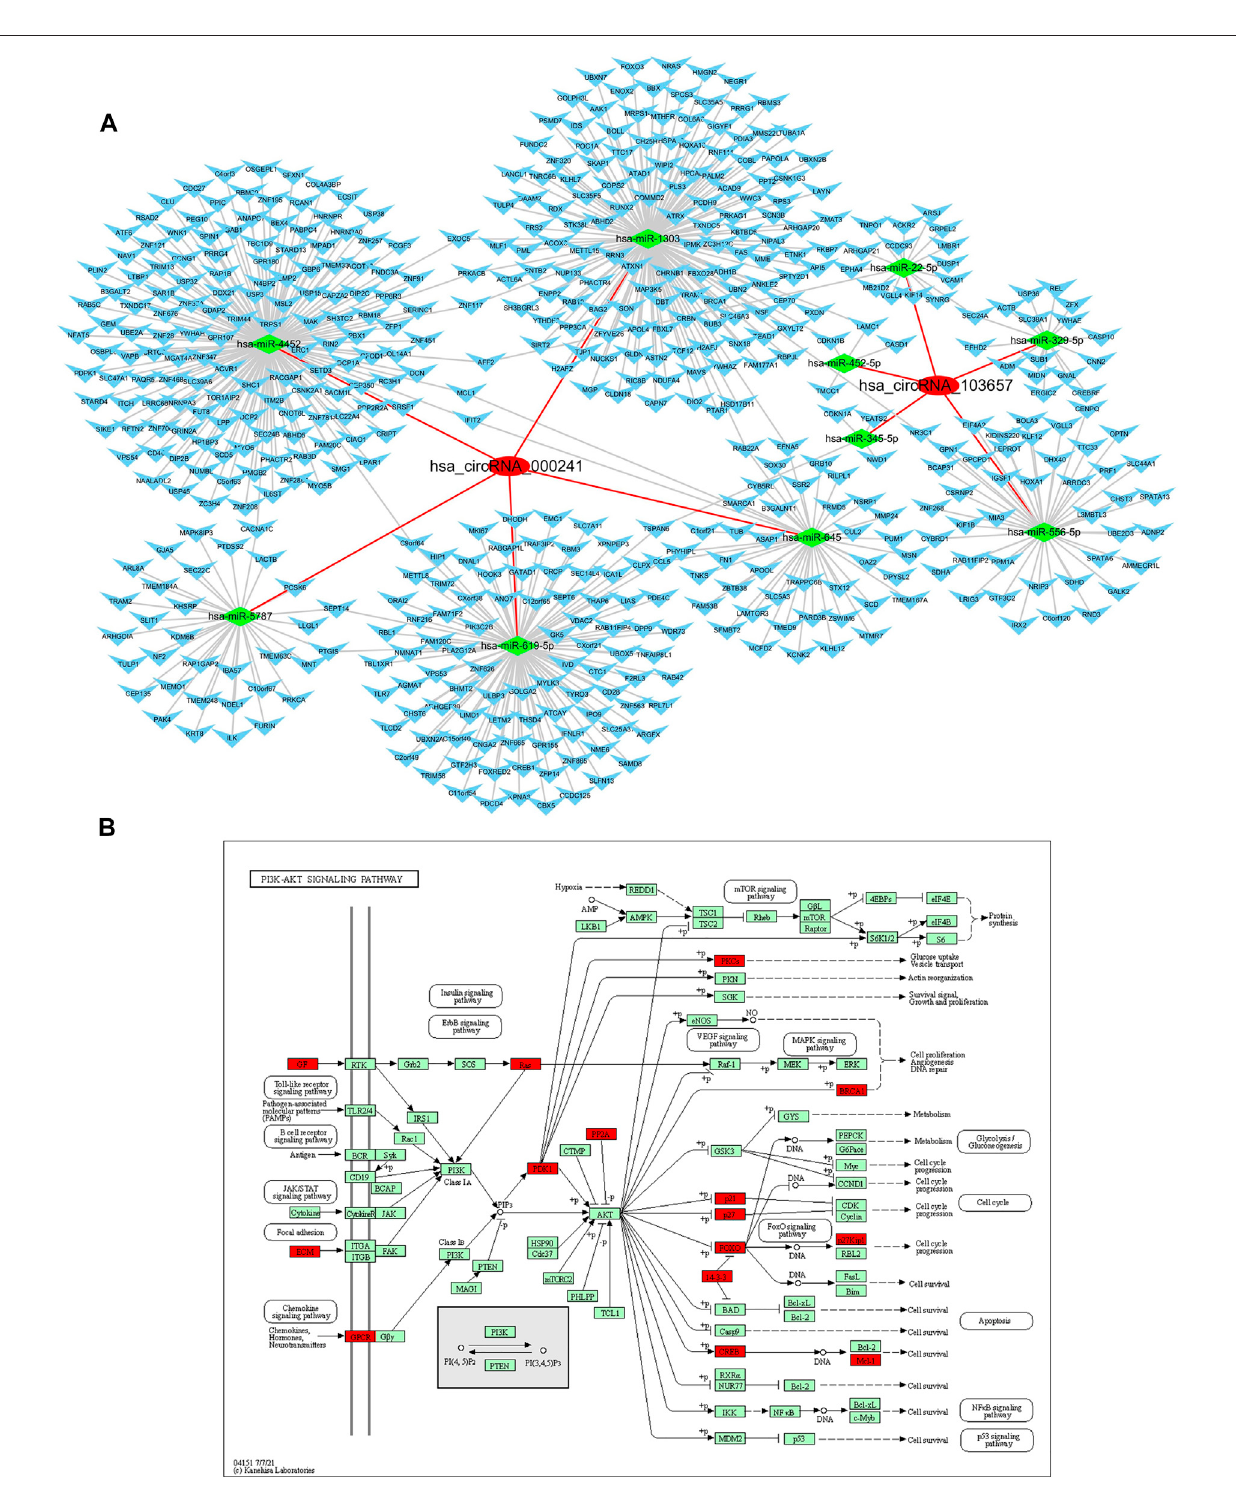
FIGURE 3 | Prediction and annotation of hsa_circRNA_103657 and hsa_circRNA_000241 ceRNA mechanism. (A) Construction of the circRNA-miRNA-mRNA network: the network of ceRNA includes 2 circRNAs, 10 miRNAs, and 525 mRNAs. (B) Schematic diagram of the gene category of the PI3K-Akt signaling pathway, which is the top enriched term in the KEGG pathway analysis. Image from the Kyoto Encyclopedia of Genes and Genomes (KEGG) resource (http://www.genome.jp/ kegg/).